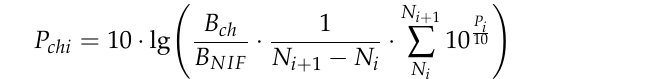
If the sampling frequency F s is 5.12 MHz and the number of points N is 2048, a resolution of 2.5 kHz is obtained. If we take into account the fact that the bandwidth of the TETRA channel is 25 kHz, it means that 10 points are used for the calculation of the channel power. Through software applications, following the processing of spectral lines resulting from the application of FFT, the TETRA signals can be characterized in detail (for example, the power of each channel can be calculated, etc.). Figure 2. At each FFT bin, the details of the TETRA signals will be considered. Starting from the fact that the TETRA spectrum occupies a bandwidth of 5 MHz centered on the frequency of 382.5 MHz in the case of Uplink and on 392.5 MHz in the case of Downlink, a sampling frequency of 5.12 MHz was established for the FFT calculation. In this way, a bandwidth of 0.12 MHz (0.06 MHz left and right, respectively, of the TETRA spectrum) remains outside of the spectrum of interest. The power of a TETRA channel is calculated through the amplitudes of the spectral lines inside the channel. Thus, for this purpose, the mathematical expression presented in [28] will be applied (2):